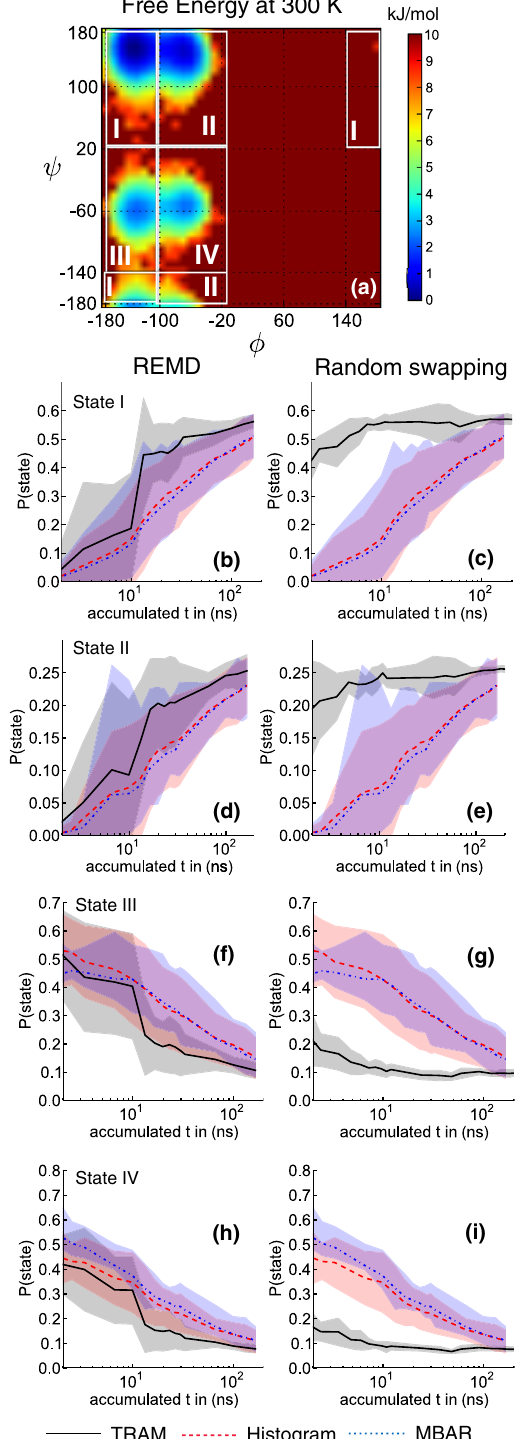
FIG. 4. (a) Free energy with a 10 kJ = mol cutoff, indicating discrete states. (b, d, f, h) REMD simulation convergence of state probability over ten realizations. Estimates are obtained from xTRAM (black, continuous line), MBAR (blue, dashed-dotted line),and direct counting(red,dashedline).(c,e,g,i)RSsimulation convergence of state probabilities over five realizations, compared to REMD simulation estimates using MBAR and direct